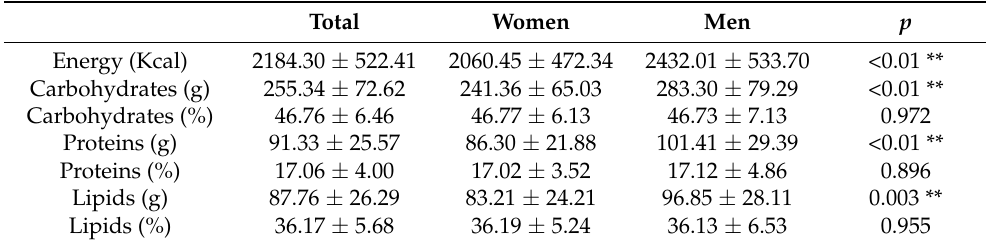
Table 1. Consumption of energy, carbohydrates, proteins and lipids ( n = 162) according to 3-24 HR. Total Women Men p Energy (Kcal) Carbohydrates (g) Carbohydrates